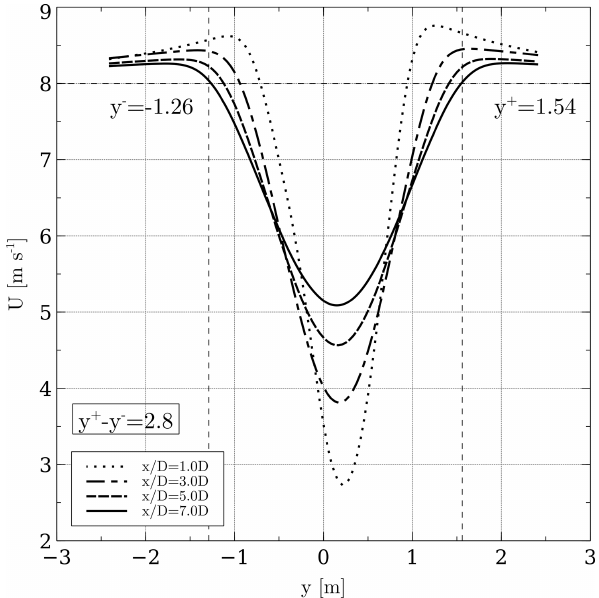
Figure 8. Wake width at different downwind stations. The width begins to reach a stable value at 7 D , and its value is